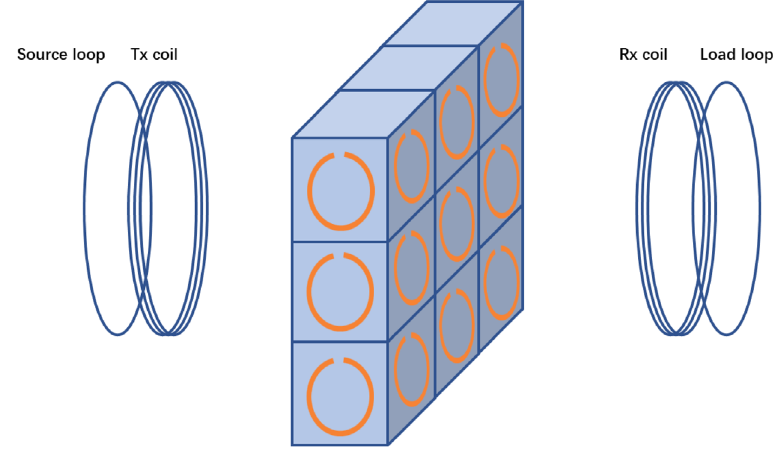
Fig. 9. Three-dimensional cuboid structure NPM.